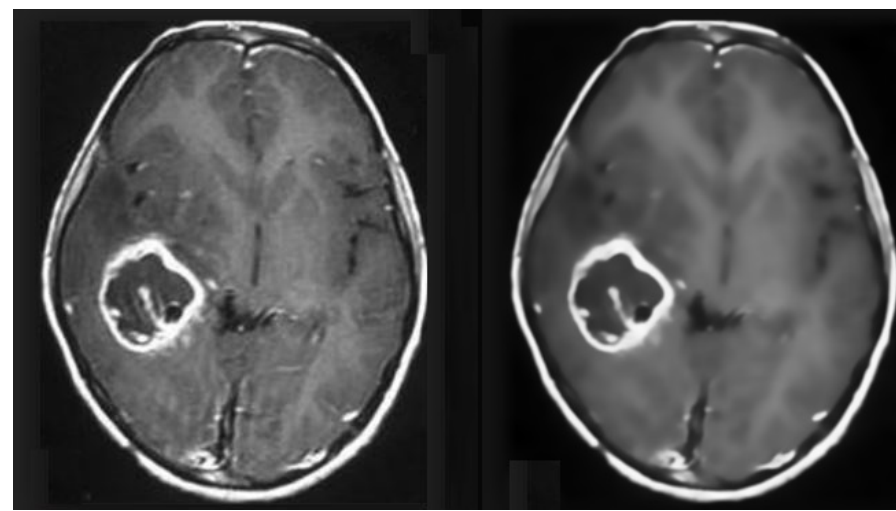
Figure 8. Pre-processed MRI data (Before and After